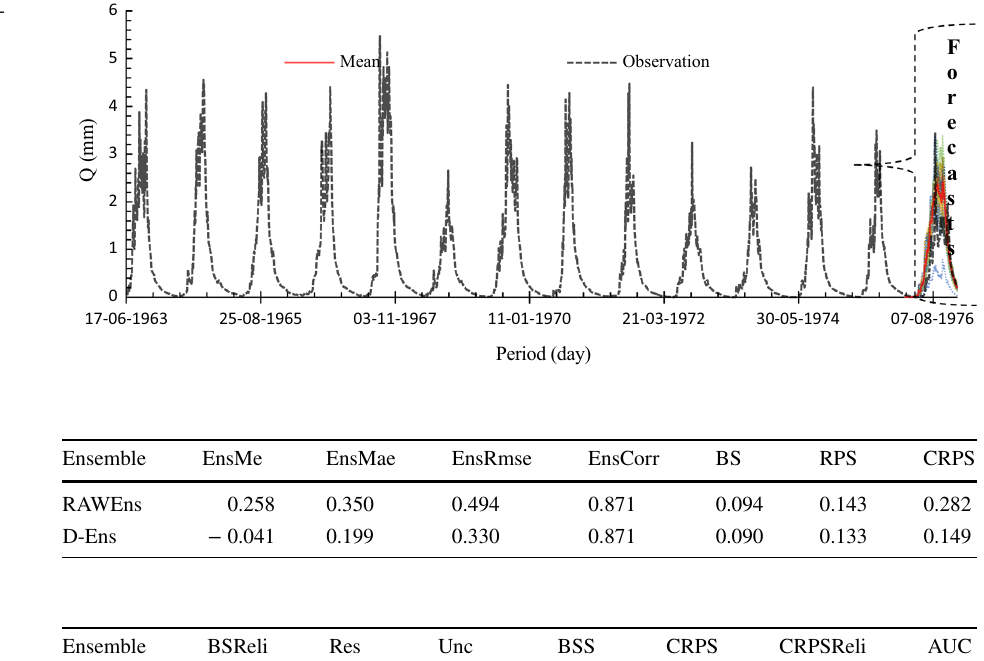
Table 3 Attributes of the forecasting